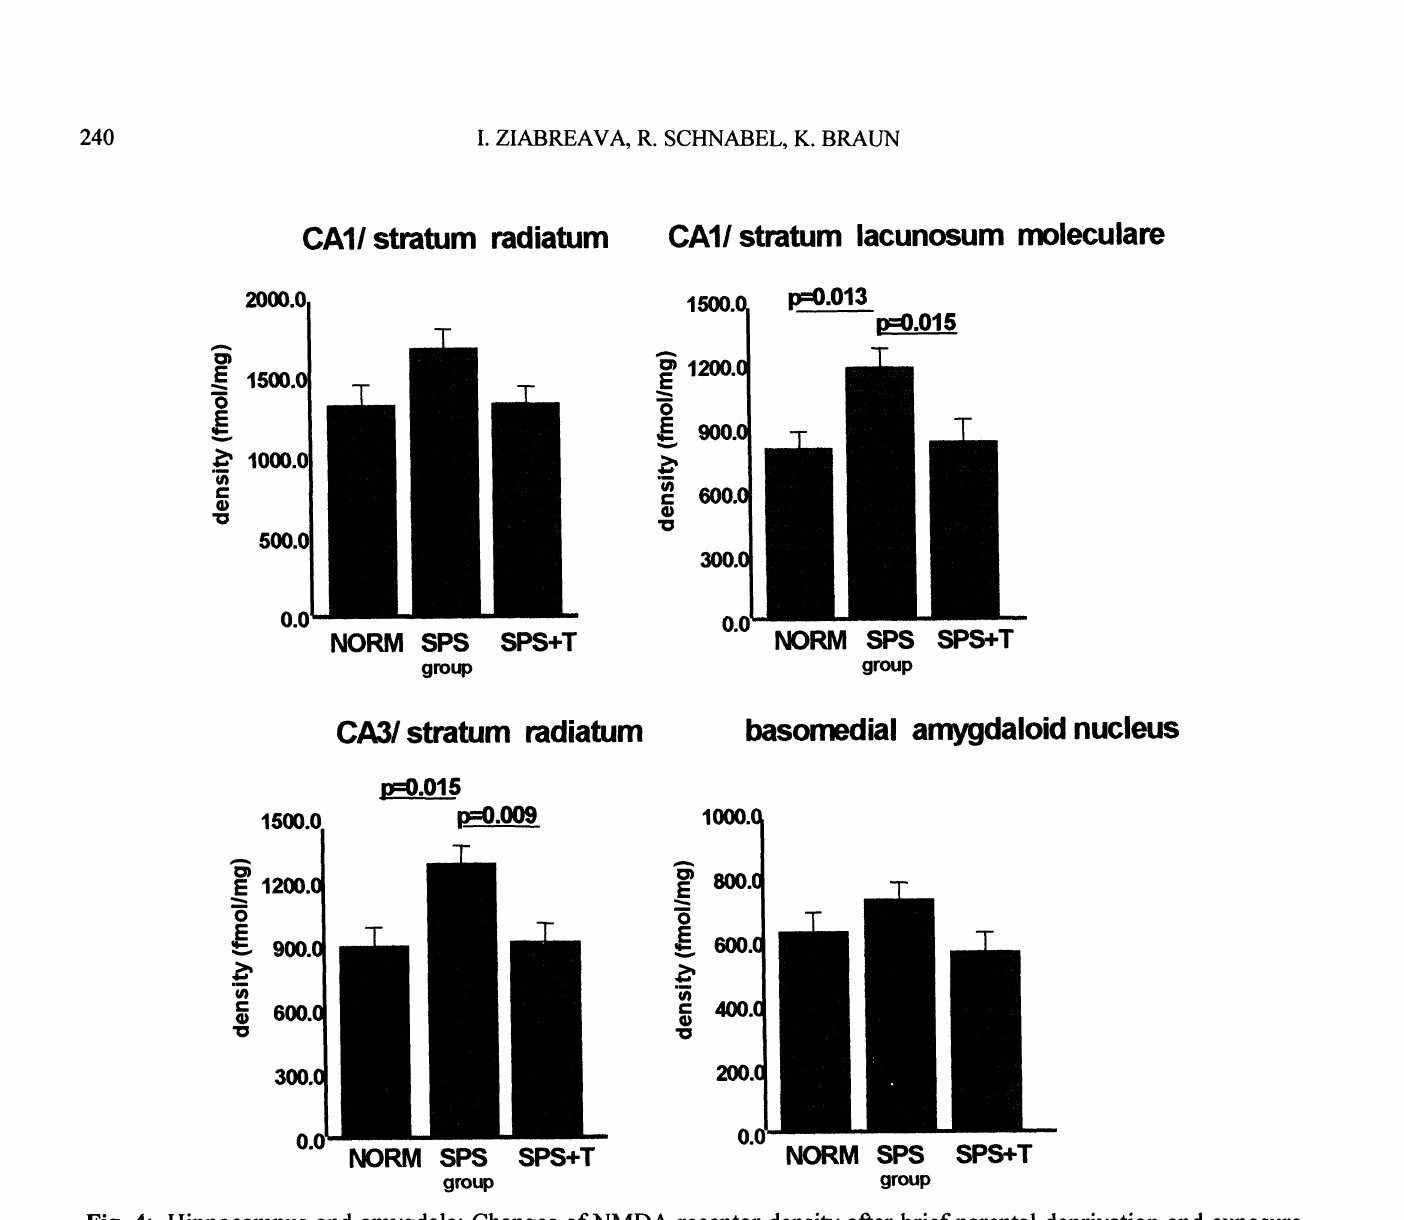
Fig. 4: Hippocampus and amygdala: Changes of NMDA-receptor density after brief parental deprivation and exposure to a novel environment (open field) with (SPS+T short parental separation + tone) and without (SPS short parental separation) presentation of parental vocalization. Values are mean + standard